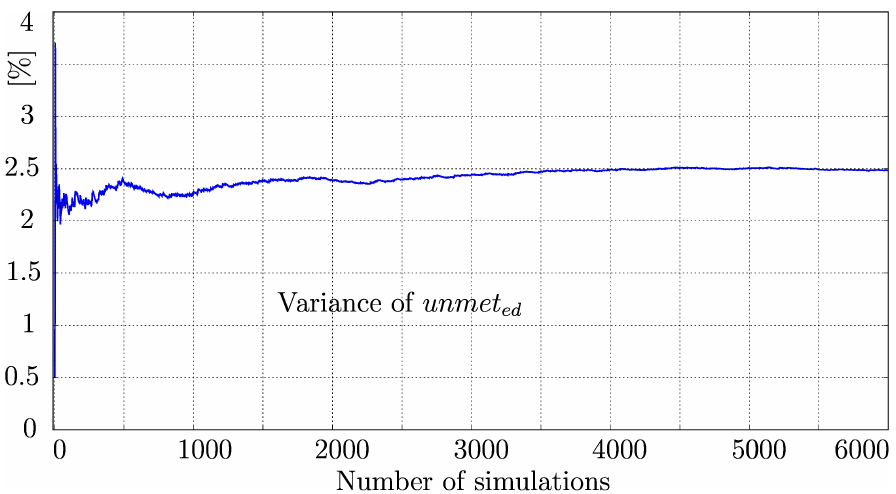
Figure 10. Variance of the unmet ed (Var( unmet ed )) computed for 6000 simulations. Each simulation was obtained from a different initial condition of z ( z ( 0 )